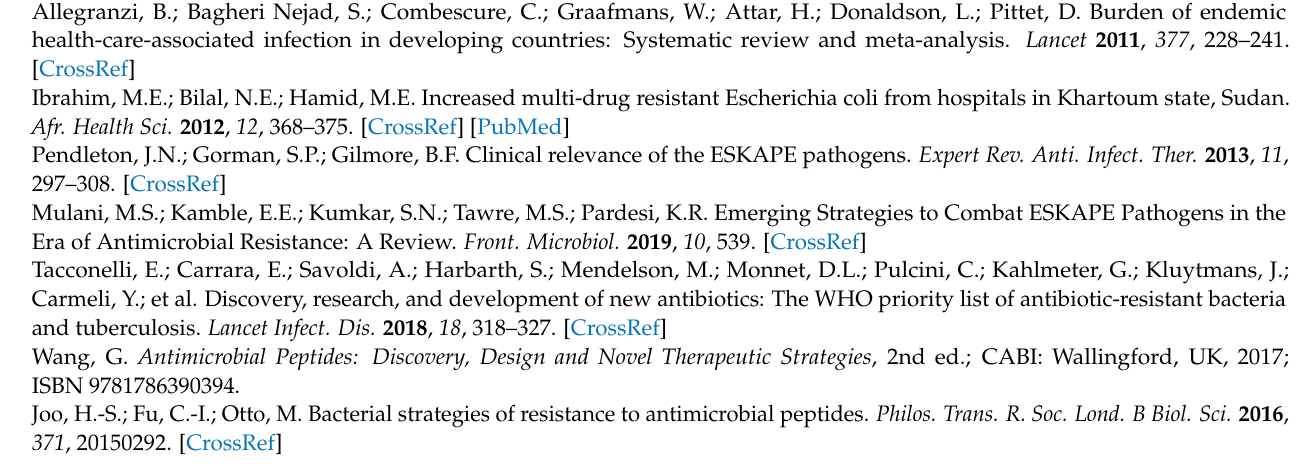
S6: Occurrence of polar atom contacts between K11 peptide and various membrane bilayers, Figure S7: Area per lipid in bilayers containing various phospholipids compositions as calculated from MD simulations in the presence of eight K11 peptides, Figure S8: Order parameter of C-H moieties in palmitoyl side chains in membranes containing various phospholipids compositions as calculated from multiple repetitions of MD simulations in the absence (2 repetitions in black labeled as 1 and 2) and in the presence (3 repetitions in red labeled from 1 to 3) of eight K11 peptides. The panel in the right bottom corner is an example of MD snapshot with POPE/POPG bilayer (color code in the caption of Figure 4). TOCL2 refers to CL, Figure S9: Electron density profiles for POPC, POPG and POPE/POPG/CL in presence of eight K11 peptides, Figure S10. Order parameter of C-H moieties in palmitoyl side chains in membranes containing various phospholipids compositions as calculated from multiple repetitions of MD simulations in the absence (2 repetitions in black labeled as 1 and 2) and in the presence (3 repetitions in red labeled from 1 to 3) of K11 peptide initially placed inside the bilayer. The panel in the right bottom corner is an example of MD snapshot with POPE/POPG/CL bilayer (color code in the caption of Figure 4). TOCL2 refers to C, Figure S11: Analytical purity of K11 peptide; Table S1: 1 H and 13 C NMR assignment of K11 peptide, Figure S12: Convergence analysis of the simulation of K11 peptide in the presence of POPE/POPG membrane. (A) Peptide RMSD (C α carbon); (B) Polar contact block analysis in time